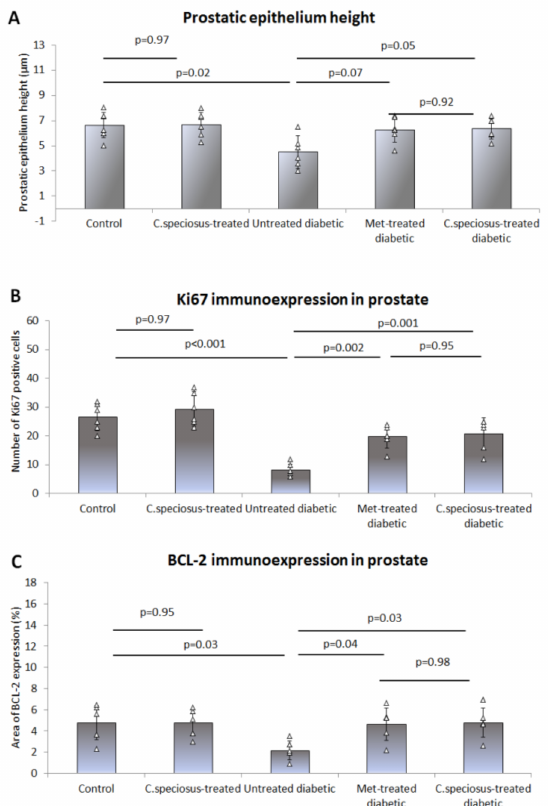
Figure 5. Prostatic epithelium height ( A ), immunoexpression of Ki67 ( B ) and BCL-2 ( C ) were measured in the ventral prostate of the studied groups. Results are presented as mean ± SD, n = 10. The studied groups are compared using one-way ANOVA test followed by Bonferroni post-hoc test. Significance is considered at p <